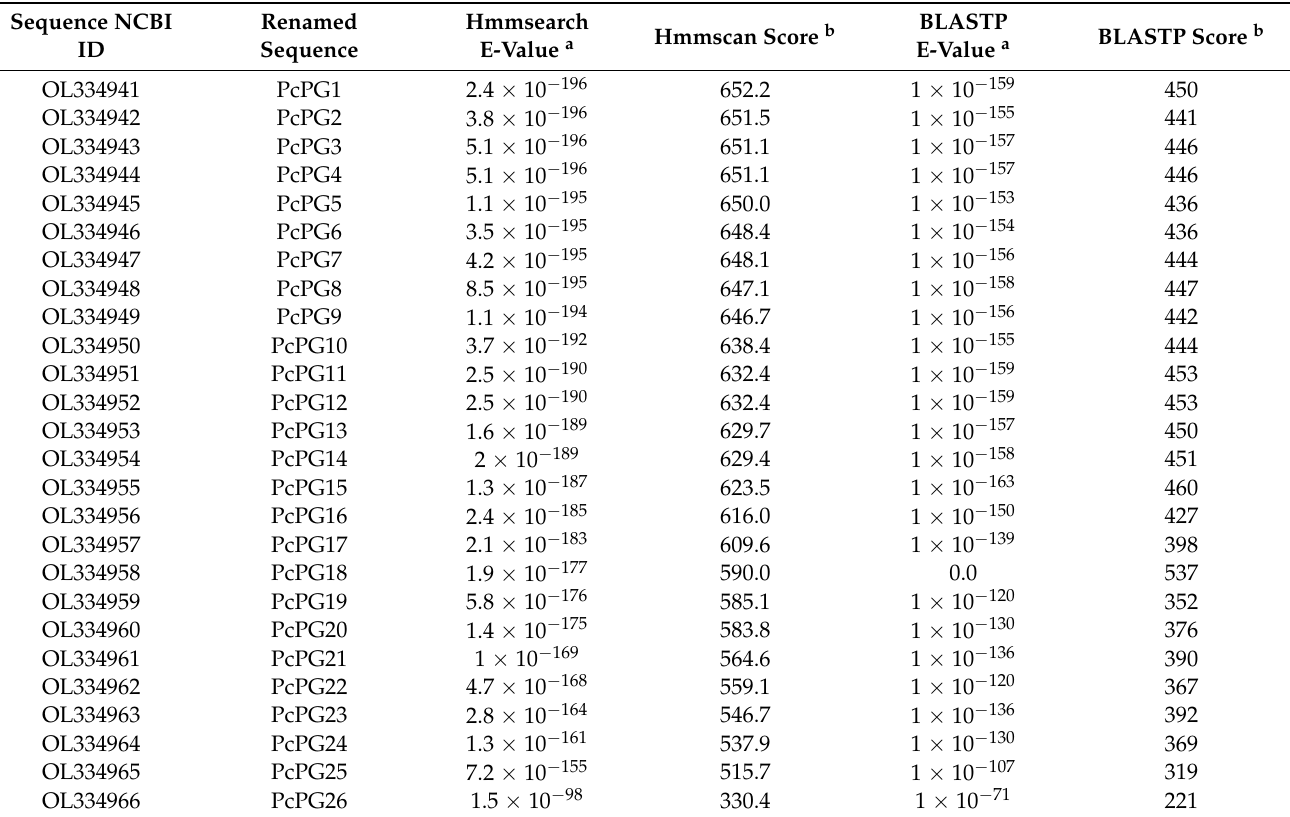
Table 2. Results of the endopolygalacturonase proteins from the hmmsearch and BLASTP